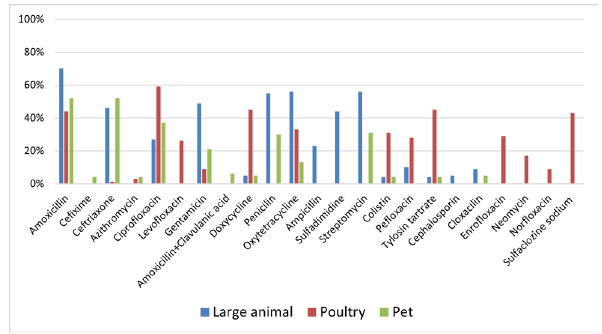
Figure 3: List of commonly prescribed antimicrobials in large animals, poultry, and pet animals